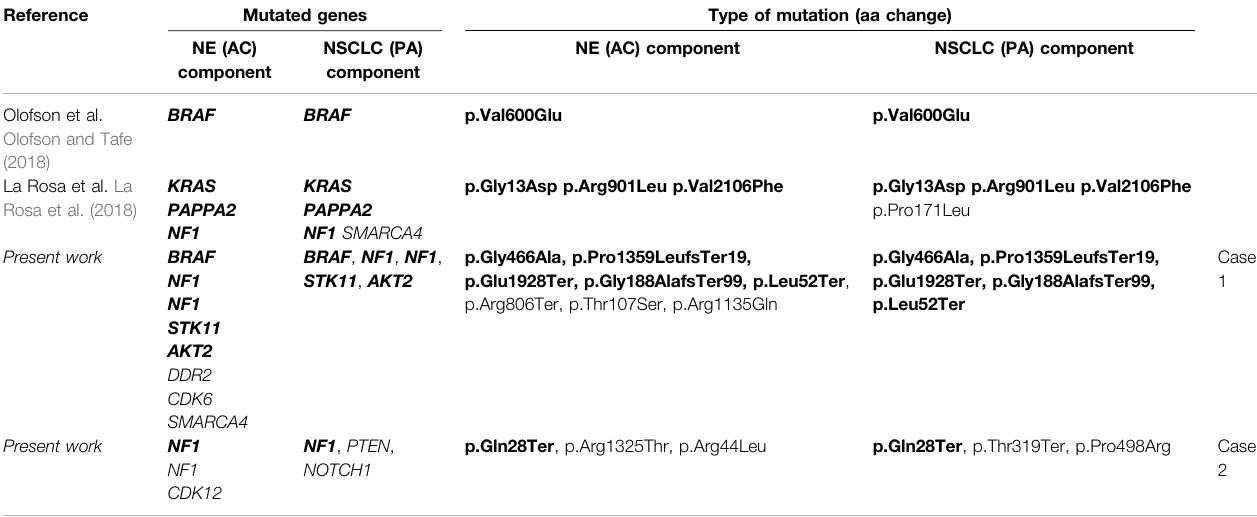
TABLE 2 | Molecular pro fi le of published combined pulmonary adenocarcinoma and atypical carcinoids of lung primary site of neoplasms.